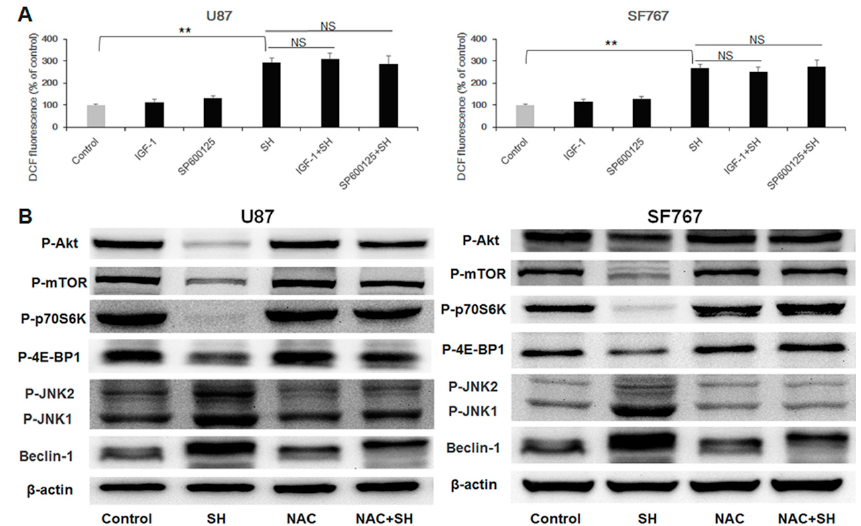
Figure 5. ROS production is upstream of JNK pathway activation and Akt-mTOR pathway inhibition in SH-mediated autophagy ( A ) Effects of IGF-1 and SP600125 on SH-induced ROS generation in U87 and SF767 cells. The cells were exposed to SH (0.5 mM) in the absence or presence of IGF-1 or SP600125 for 24 h, and intracellular ROS levels were investigated using DCFH-DA probes, with the resulting fluorescence being read by a fluorescence microplate reader; ( B ) Effects of NAC on SH-mediated Akt-mTOR pathway inhibition and JNK pathway activation in U87 and SF767 cells. The cells were treated with SH (0.5 mM) for 24 h in the absence or presence of NAC. β -actin was used as the loading control. All blots shown are representative of n = 3 experiments, with similar results. Data are expressed as the mean ± SEM, n = 3. ** p < 0.01, versus the control. NS, not significant versus the group treated with SH alone.